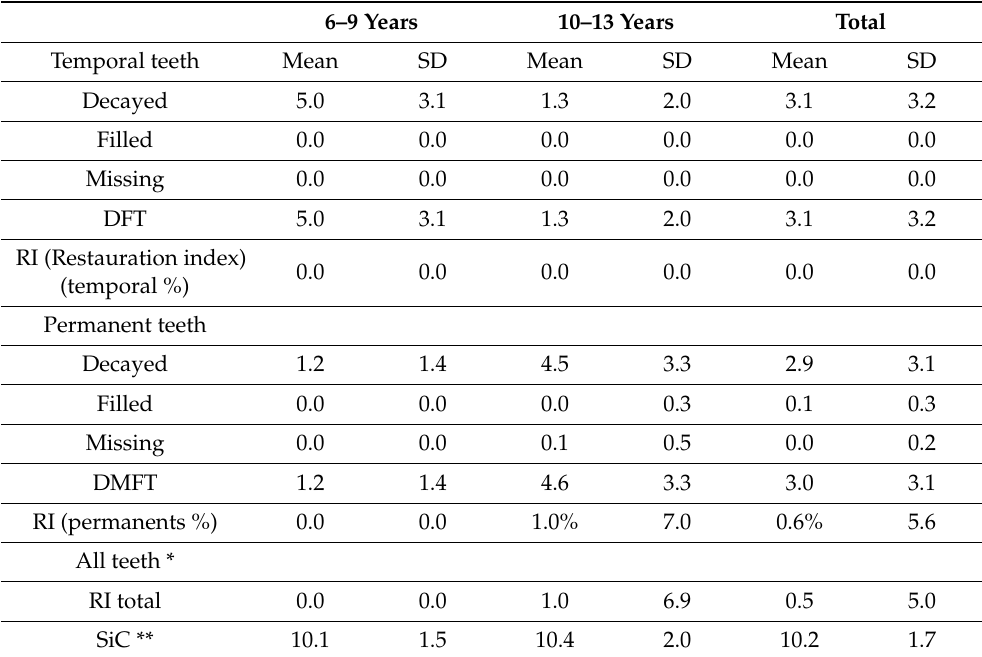
Table 2. Clinical description of caries status in the sample according to age